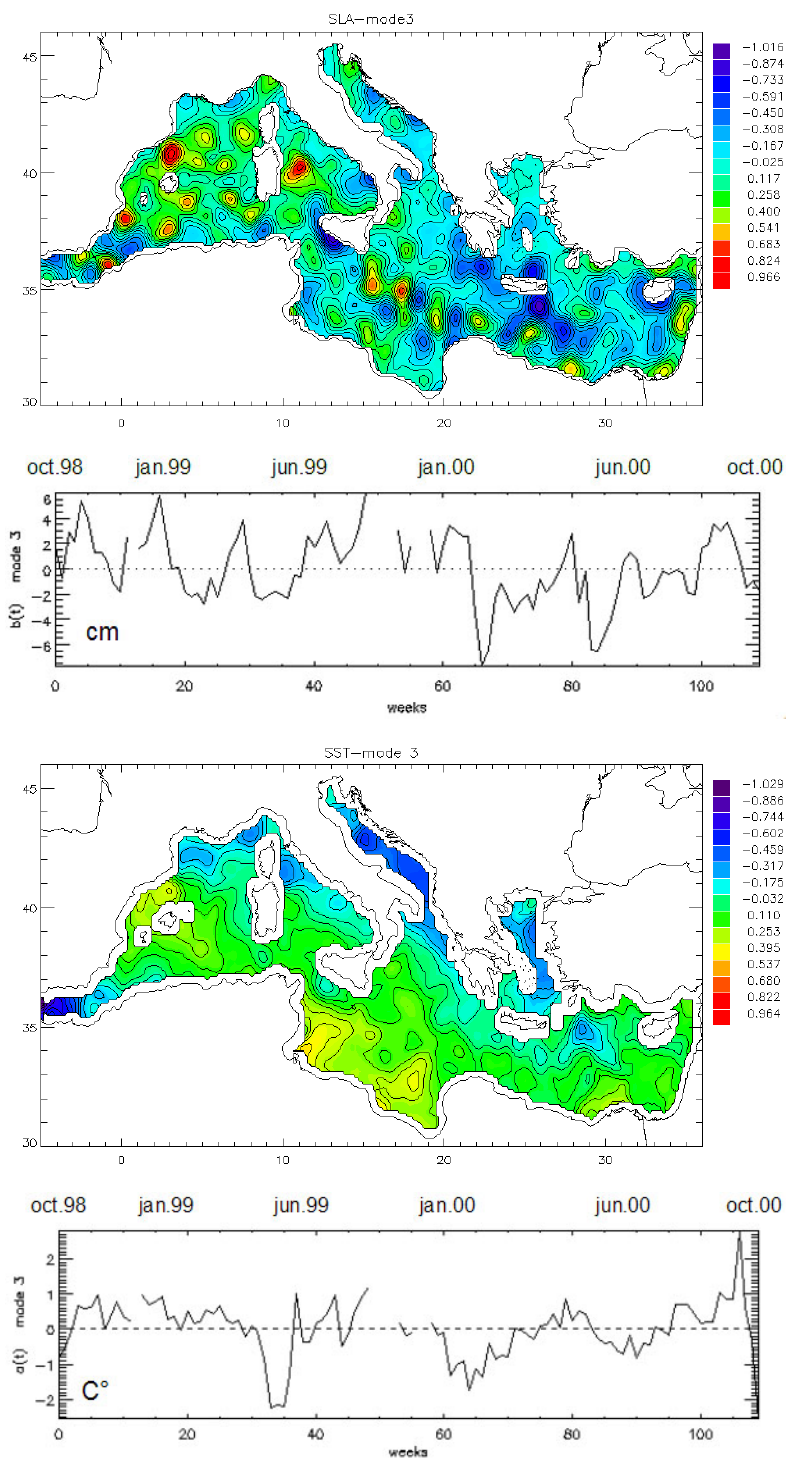
Fig. 9. Third “gradient CPA” mode of SLA and SSTA data collected during MFSPP. Patterns and associated temporal coefficients: (a) SLA pattern, (b) SLA temporal coefficient, (c) SST pattern, (d) SST temporal